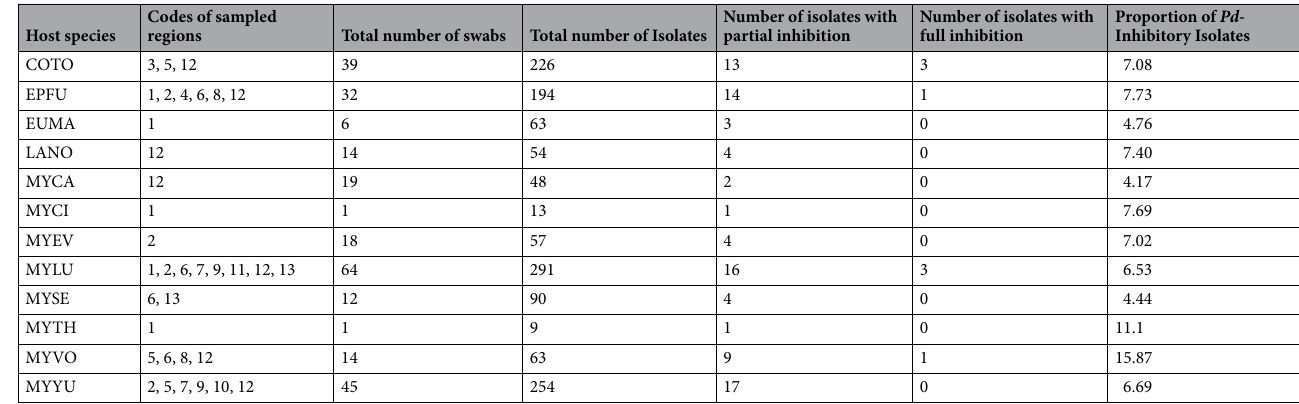
Table 1. A summary of the total number of bacterial strains with inhibitory activity against Pd